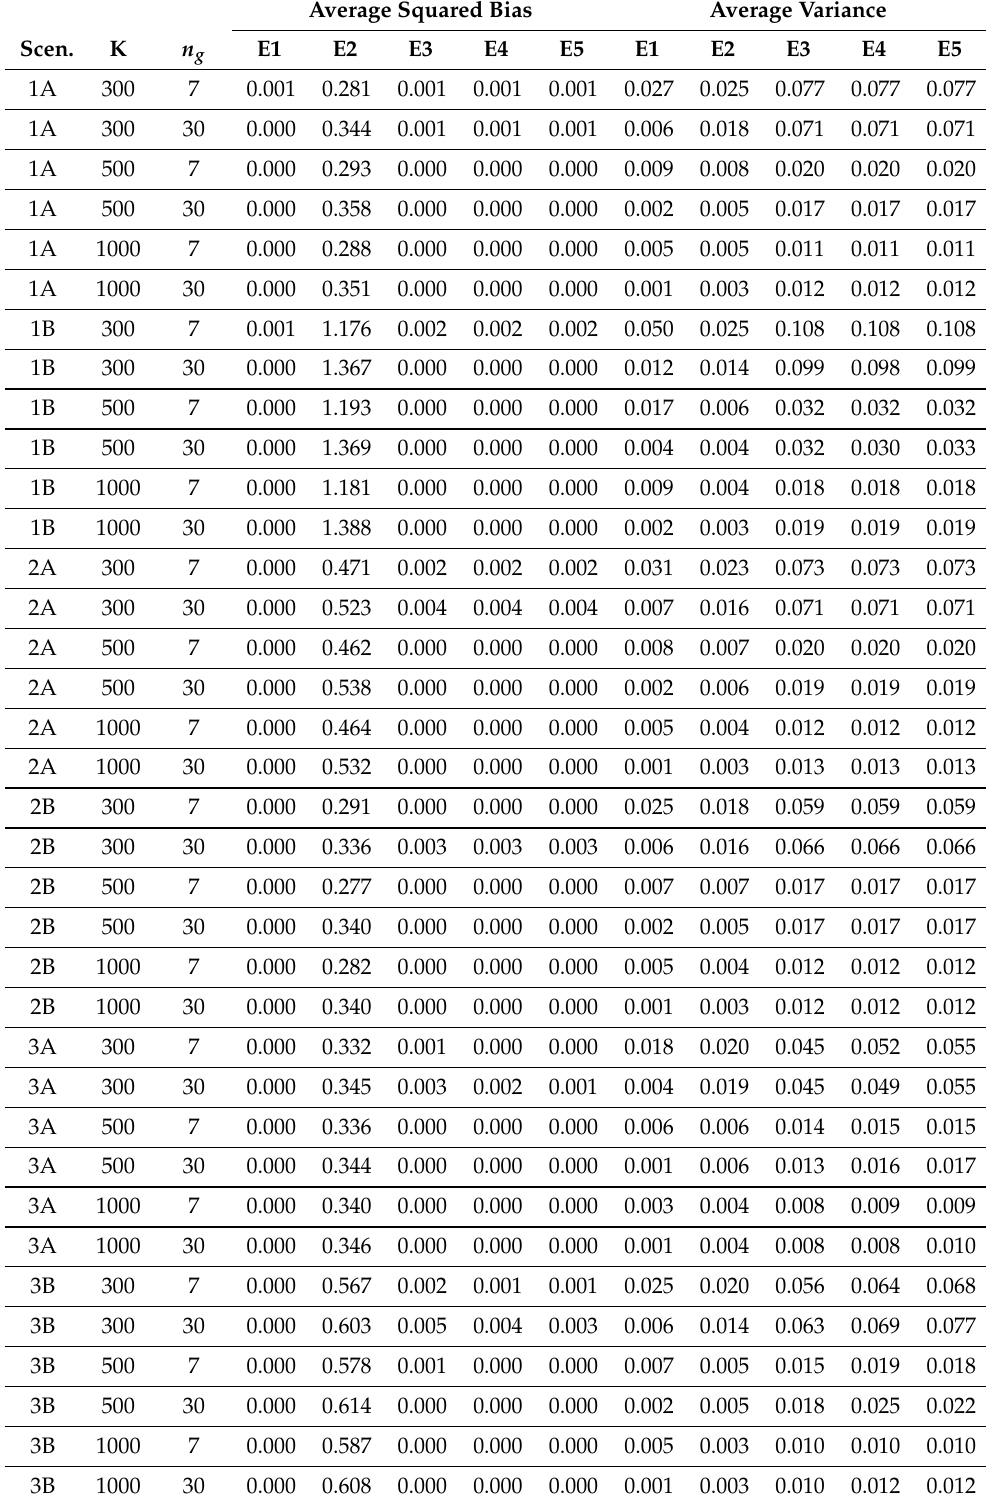
Table 1. Average Squared Bias and Variance of Estimators E1 to E5 in Scenarios 1A to 3B. K is the sample size of the aggregate data. n g is the group size in the